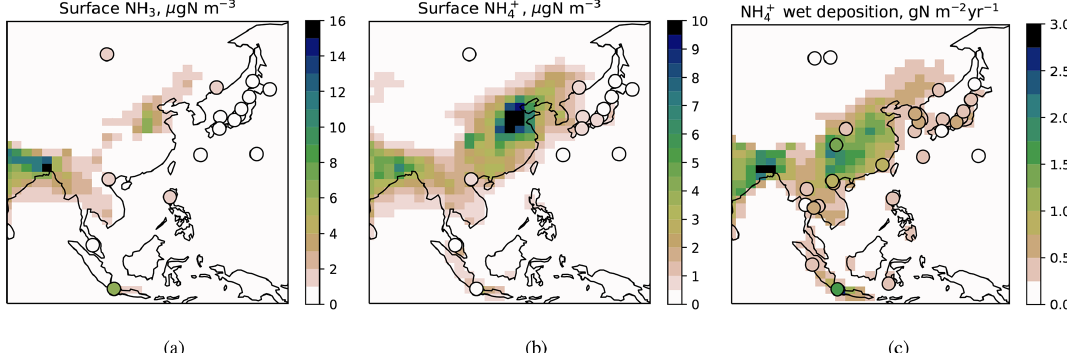
Figure 4. Ammonia (a) , ammonium (b) and wet deposition of ammonium (c) in the FAN simulation for East Asia (shading) and in the EANET observations (markers). The other simulations are shown in Fig.